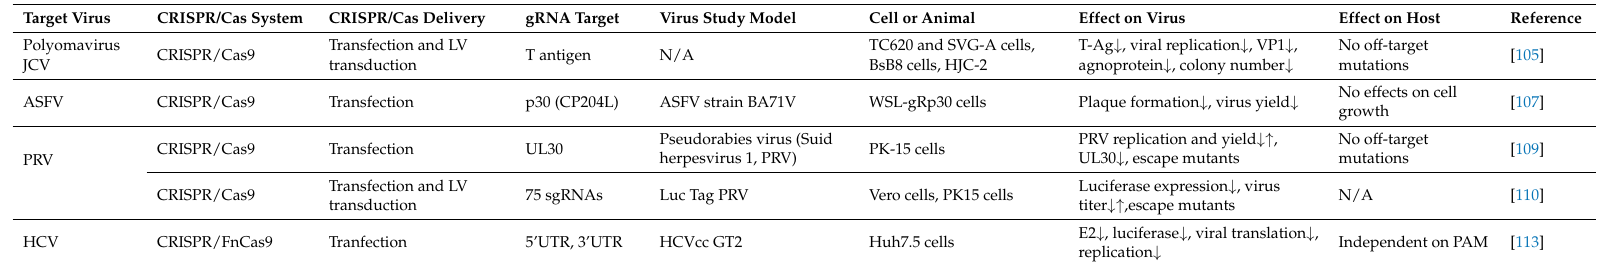
Table 5. Summary of CRISPR/Cas9-based antiviral studies targeting various viruses. Abbreviations used within the table are as follows. JCV: JC virus. T-Ag: T antigen. ASFV: African swine fever virus. PRV: pseudorabies